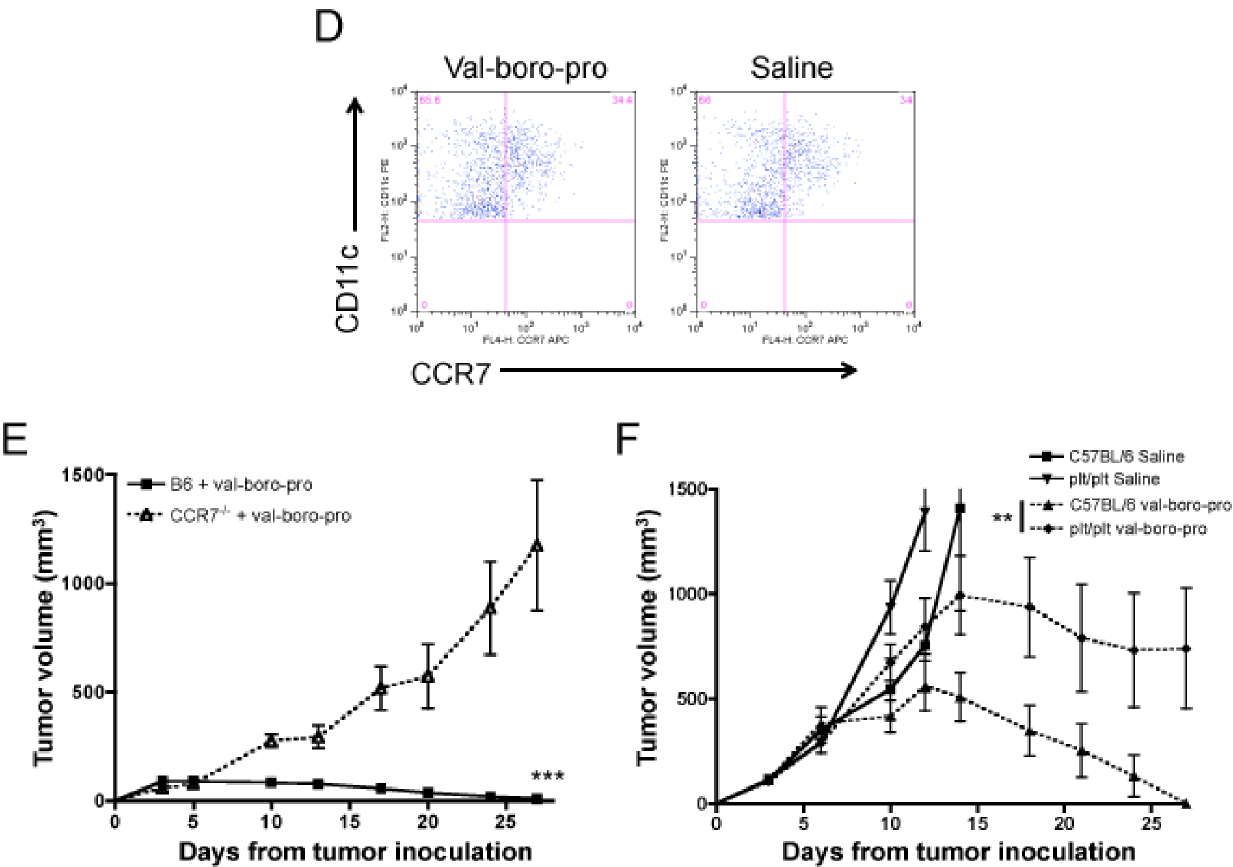
Figure 9. Val-boroPro-mediated acceleration of DC trafficking depends, in part, on the CCR7-CCL19/21 chemokine axis. (A) No change in CCR7 expression on DCs from Val-bor-Pro treated mice. Representative dot plots of gated CD11c + CD11b + cells from MB49-bearing mice that were treated with Val-boroPro or saline during week one (days 3–7) and the first day of week two. Mice were sacrificed on day 10 and TDLN were harvested and stained for flow cytometry. (B) CCR7 2 / 2 chimeric mice were generated by transplanting T cell depleted bone marrow (5 6 10 6 ) from CCR7 2 / 2 mice into lethally irradiated C57BL/6 recipients on day 2 30. C57BL/6 T cells (CCR7 + , 1 6 10 7 ) were administered to both groups on day 2 16, and mice were challenged with 10 6 MB49 on day 0. CCR7 2 / 2 chimeras (open triangles) and C57BL/6 transplanted controls (closed squares) were treated with 20 m g Val-boroPro 5 6 /week for two weeks (n=5/group). Tumor volumes were significantly larger in CCR7 2 / 2 chimerics receiving Val- boroPro compared to treated recipients of C57BL/6 wildtype bone marrow. p , 0.001 at all timepoints beyond day 10. (C) Female C57BL/6 mice and plt/plt mice were inoculated with MB49 (10 6 ) on day 0 and treated with Val-boroPro or saline 5 6 /week for 2 weeks (n=5/group). Val-boroPro-treated plt/plt mice (closed diamonds) had significantly larger tumors than treated C57BL/6 wildtype mice. P , 0.01 at all timepoints beyond day